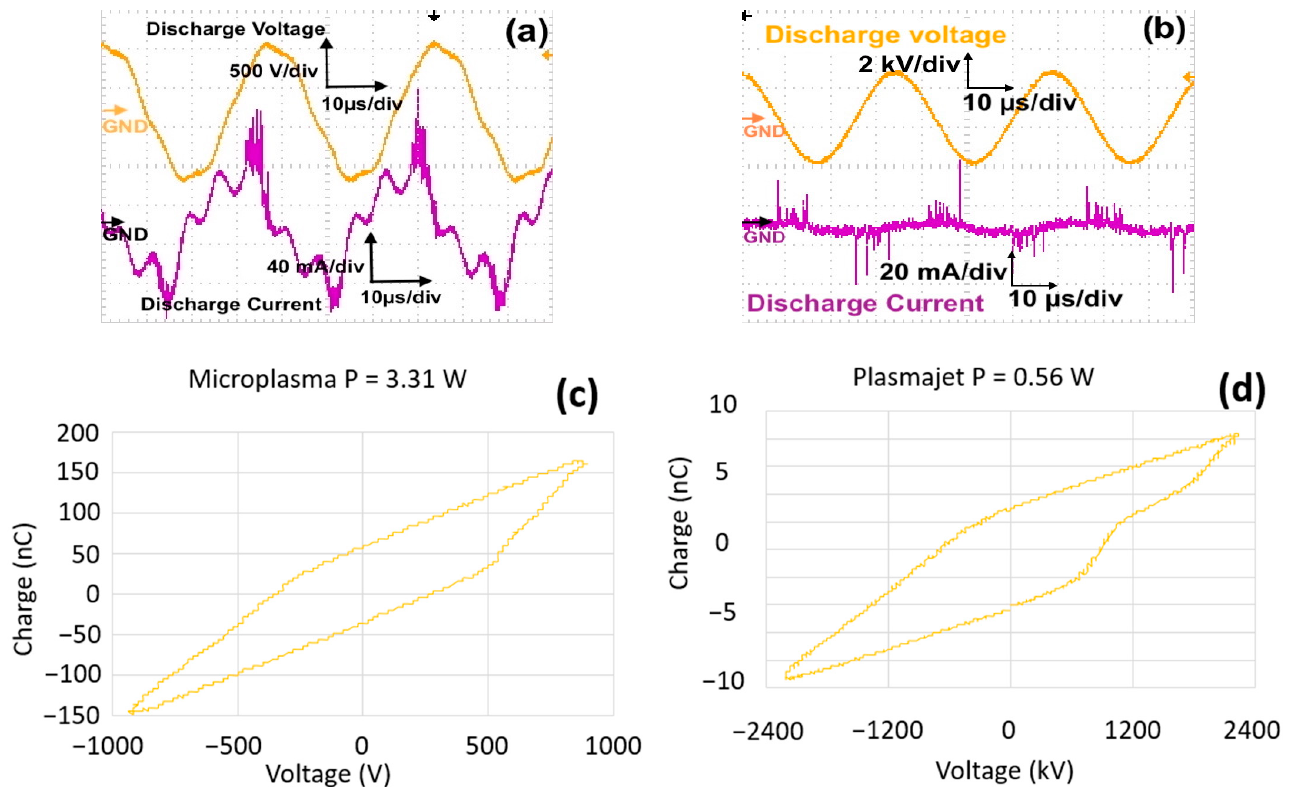
Figure 2. Discharge voltage and corresponding discharge current of ( a ) direct microplasma 900 V, air 2 L/min; ( b ) indirect treatment (plasma Jet) 2.4 kV, 1.2% O 2 3 L/min . Lissajours curve for ( c ) microplasma at 900 V, 27 kHz; ( d ) plasma jet at 2.4 kV, 30 kHz.